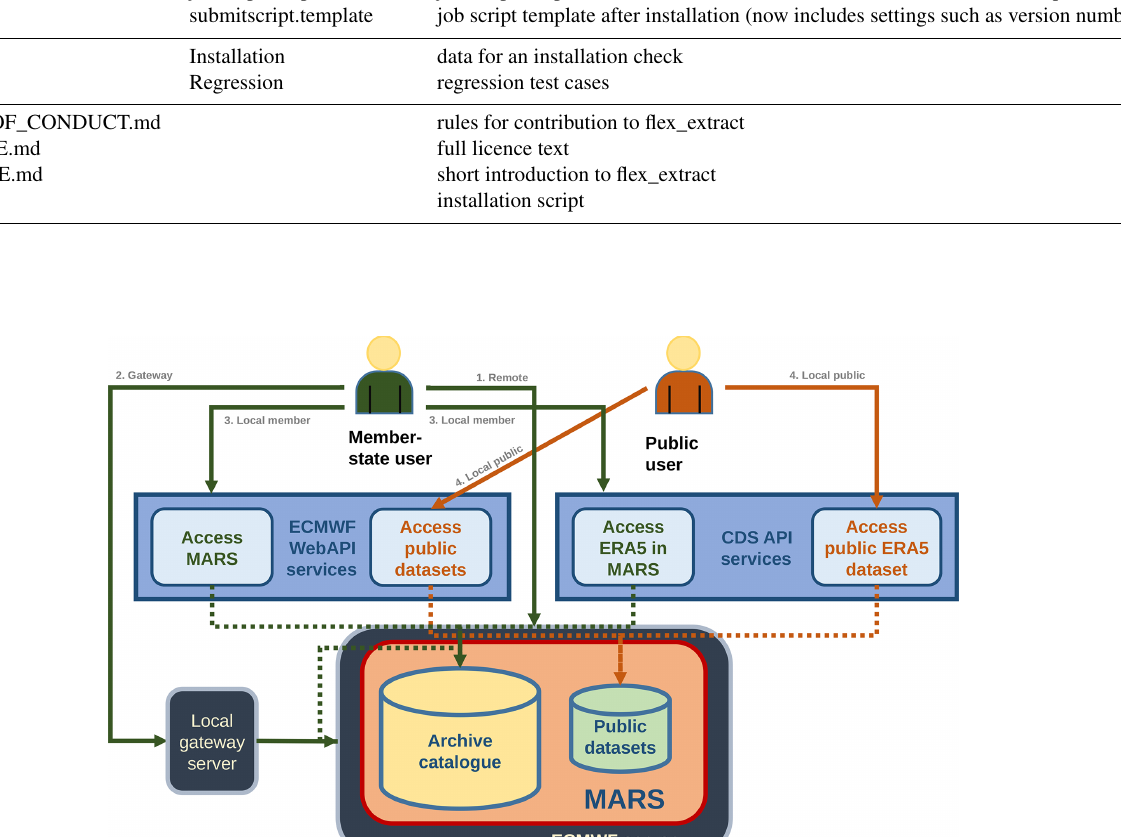
table for the assignment of parameter names and IDs